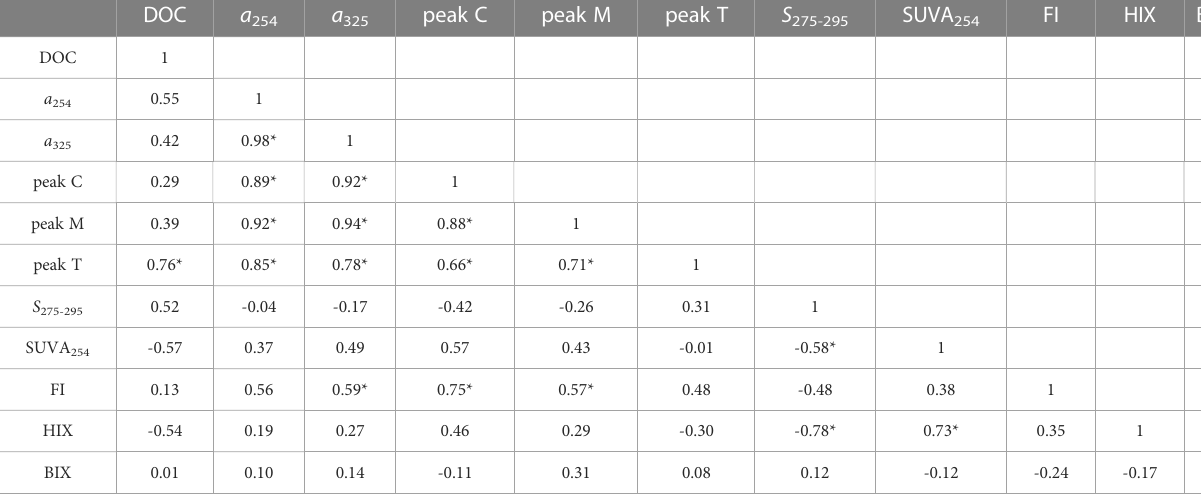
TABLE 2 Coef fi cients ( r values) of Pearson correlations between DOM